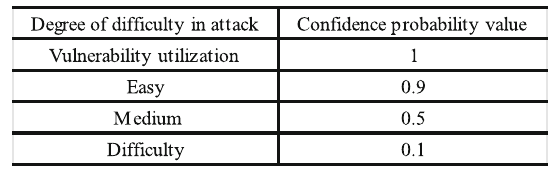
Table 10 Reference table for attack success